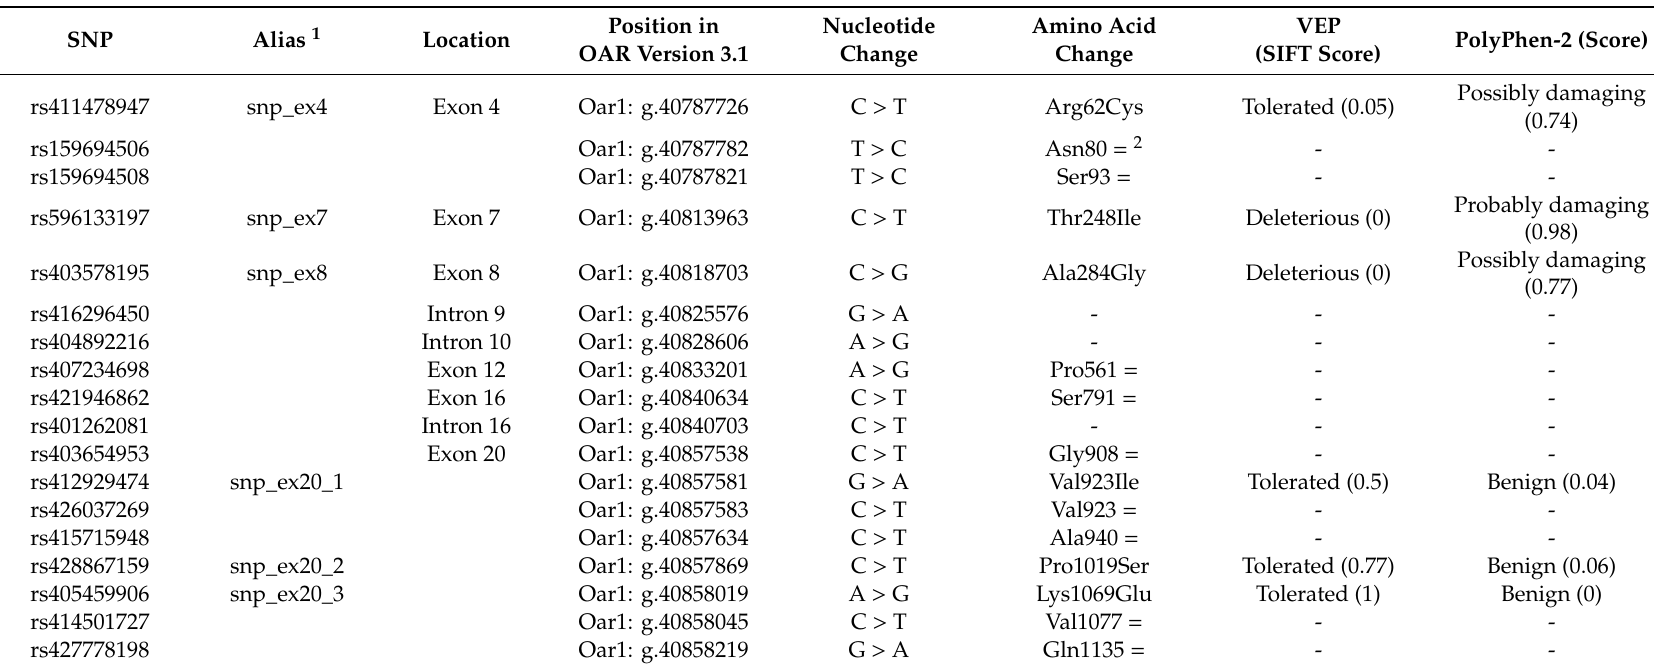
Table 2. Information about the location and amino acid substitution e ff ect of the identified SNPs according to the Variant E ff ect Predictor and PolyPhen-2 software in the LEPR gene. Scores for these programs are indicated in brackets. The SNPs are ordered according to their positions in the Oar3.1 genome version (Oar3.1: GenBank